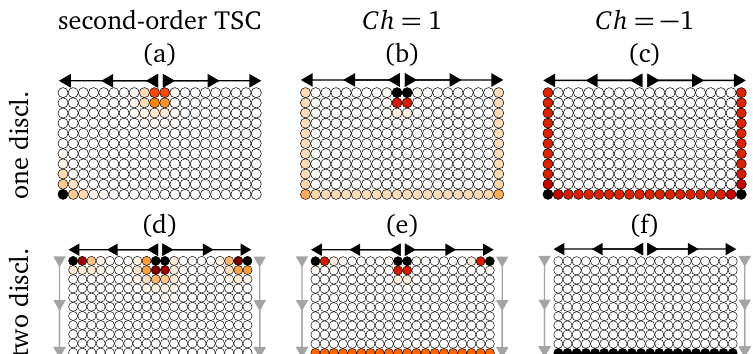
Figure 10: Model of a 2D second-order topological phase in class D protected by twofold rotation symmetry, as defined in Eq. (12), on a lattice with one and two disclinations: real-space weights for the wavefunctions of the two eigenstates with lowest absolute energy. Darker colors denote larger weights. The boundary condi- tions forming the disclinations are indicated by black and gray arrows: sites along corresponding lines of arrows are connected respecting the arrow orientation. The model is based on a two-layer stack of Chern superconductors with opposite Chern numbers Ch = ± 1. The model parameters are m = − 1 and b first column shows the full model with both layers coupled. The second and third columns correspond to the individual, decoupled layers when we set b In (e), we plot four instead of two lowest eigenstates to also indicate the presence of the chiral edge